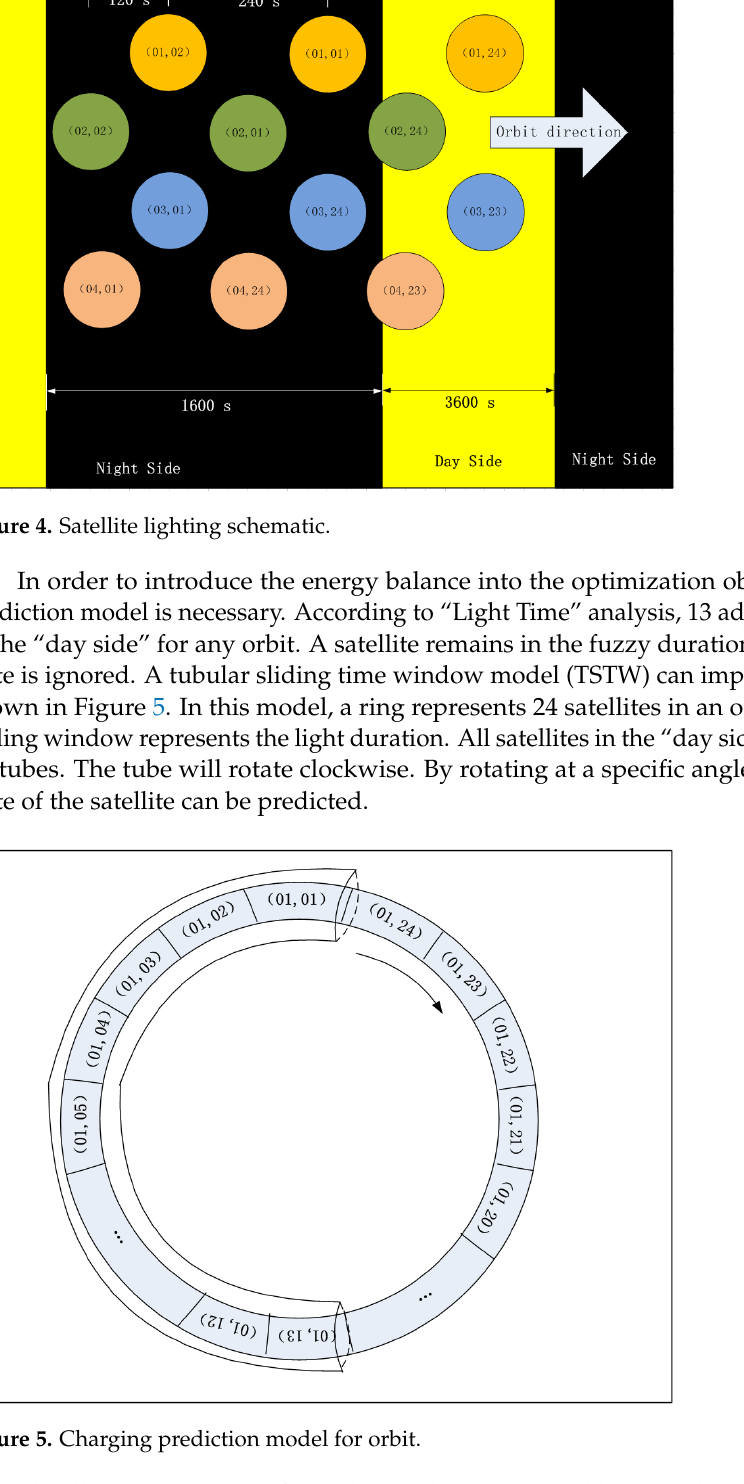
Figure 5. Charging prediction model for orbit. The illuminating state of an orbit can be represented by a single ring. A constellation applies 48 rings, and there is a one-bit delay between adjacent rings, as shown in Figure 6. With the tube rotating clockwise, satellites in different orbits are surrounded in